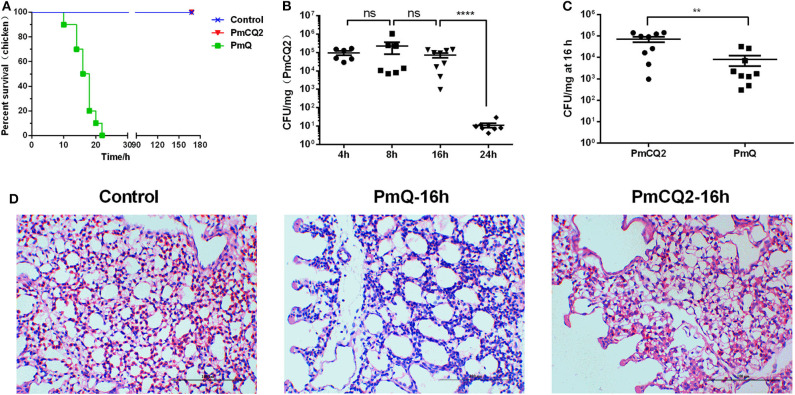
Chicken model infected with PmCQ2 and PmQ. (A) Survival curve of chickens challenged intraperitoneally with PmQ (1 × 103 CFU), PmCQ2 (2 × 109 CFU), and control (saline); (B) Bacterial burden of chicken lungs infected with PmCQ2 at 4, 8, 16, and 24 h; (C) Bacterial burden comparison of chicken lungs infected PmQ and PmCQ2 at 16 h; (D) The pulmonary histopathological examination of chicken at 16 h, stained with H&E (magnification 400X with a bar of 100 μm labeled). **p < 0.001, ****p < 0.00001, and ns, no significance.